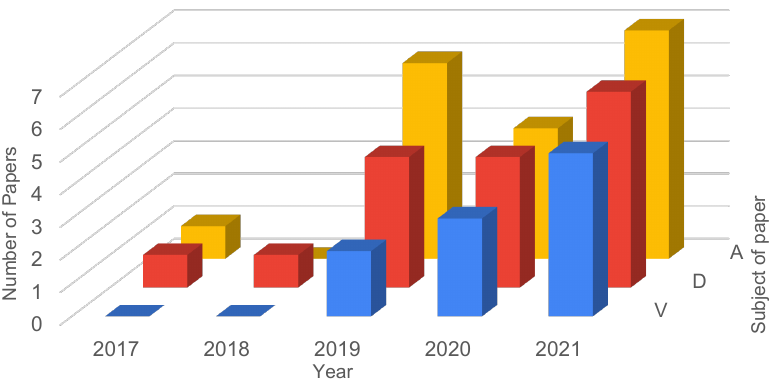
Figure 7. Review of Selected studies—number of papers focusing on vulnerabilities, attacks and